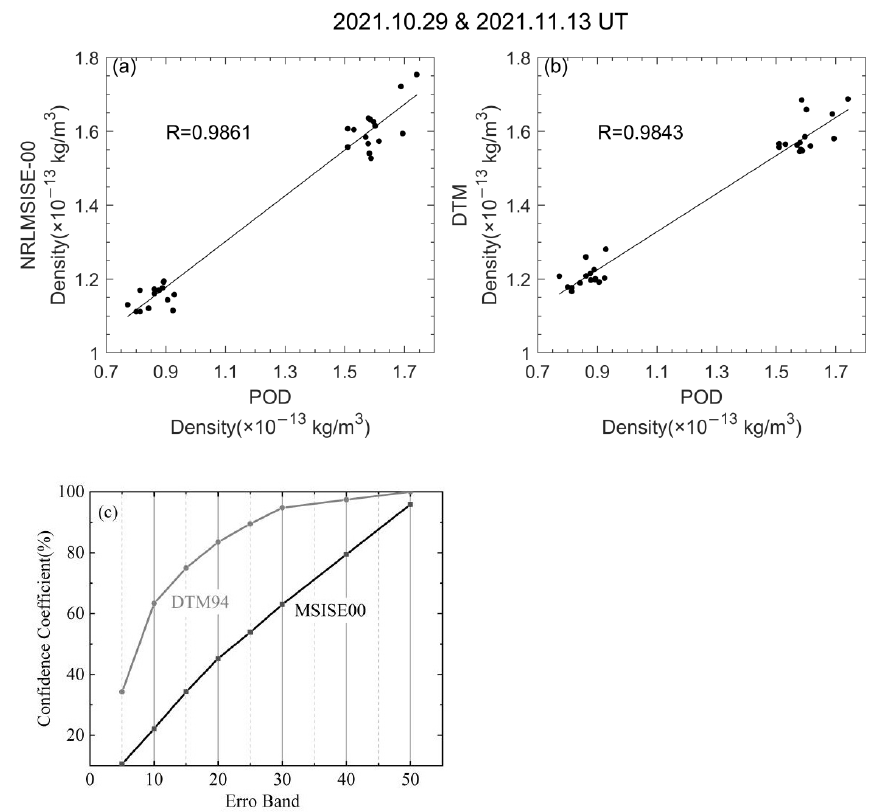
Figure 3. The correlation and error distribution between the simulations and the observations: ( a ) the correlation between the simulations by the NRLMSISE00 and the observations; ( b ) the correla- tion between the simulations by the DTM94 and the observations; ( c ) the relative error distribution between the observations and the simulations. Table 2. The error distributions of the two models relative to GPOD.